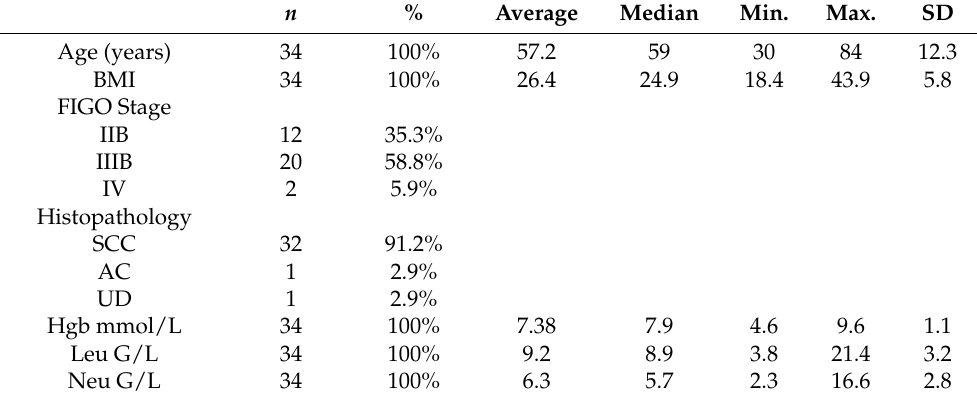
Table 1. Patient